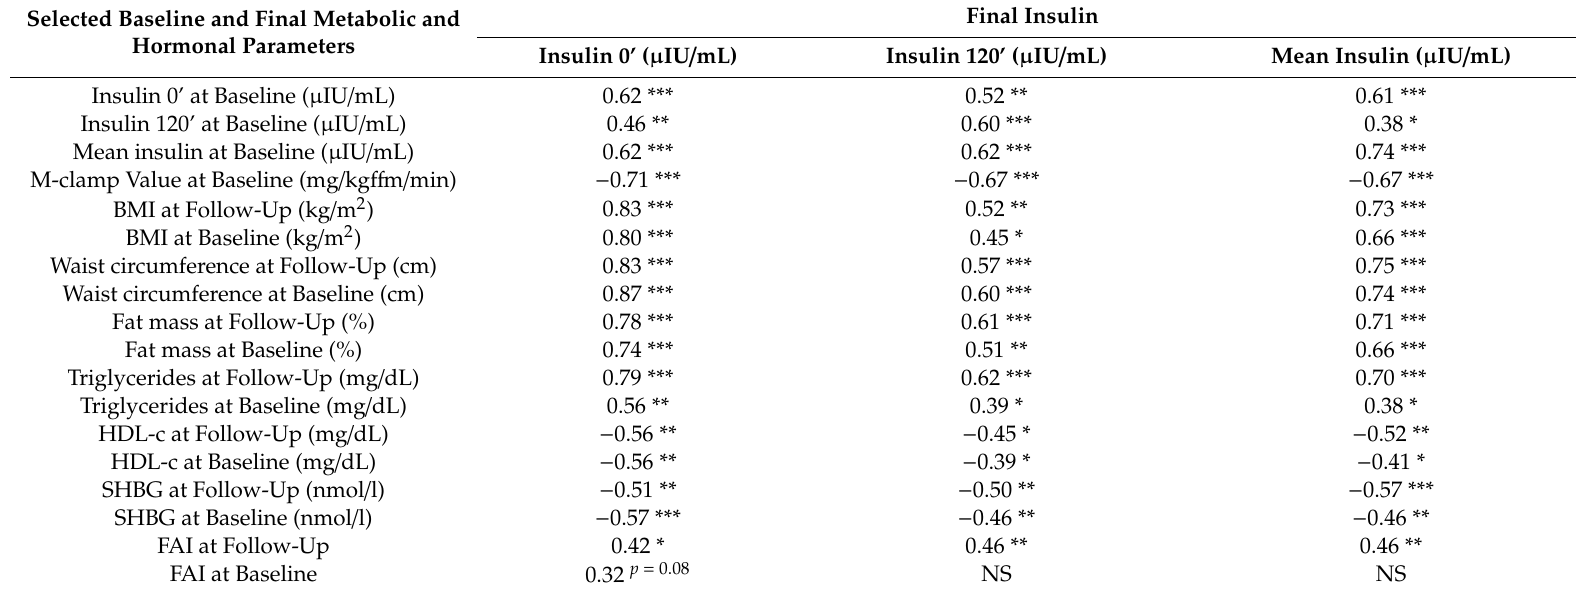
Table 6. Correlations between final concentrations of insulin and selected anthropometric, metabolic and hormonal parameters. Selected Baseline and Final Metabolic